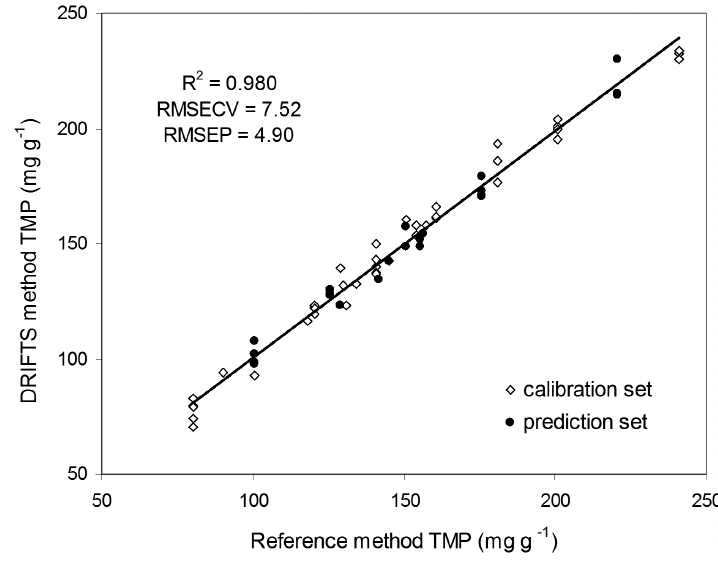
Figure 6 - Reference HPLC values versus predicted TMP values for siPLS model using 15 and 17 intervals and 6 latent